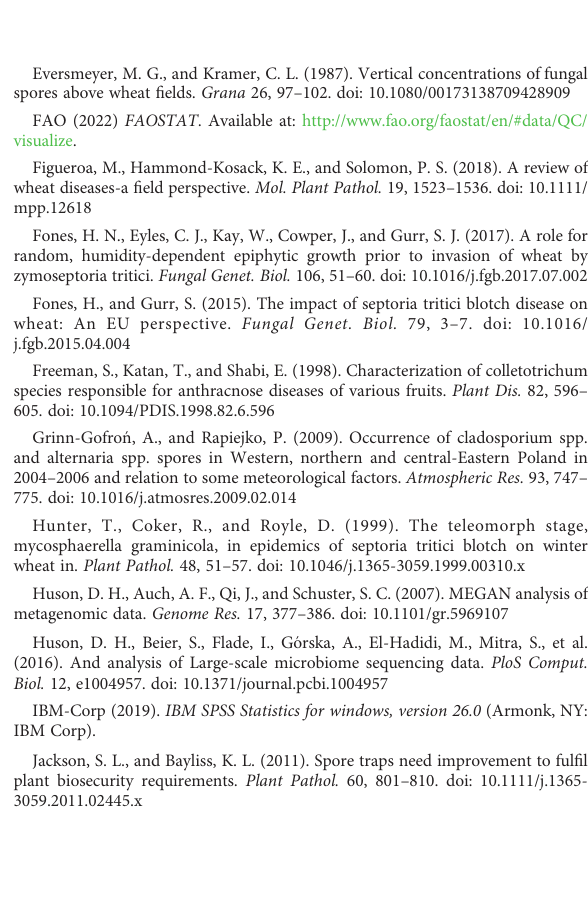
SUPPLEMENTARY FIGURE 2 BLAST species hits for 150 cereal fungal pathogen species, distributed in a cladogramtree;eachnodecontains12boxesrepresentingthe12samples (3 monthly samples for the four UK wheat fi eld sites). Colour shading of the boxes indicates the percentage of BLAST hits relative abundance in that speci fi c clade for the speci fi c sample. The white color represents 0% increasing through green shading to dark green representative of 100%. Tree built with MEGAN 6. SUPPLEMENTARY FIGURE 3 Stacked taxa barchart showing therelative abundanceat the generallevel from the Kraken2 tool, only eight out of the most abundant 66 genera recognized were fungal organisms. Bar chart was built using OmicsBox